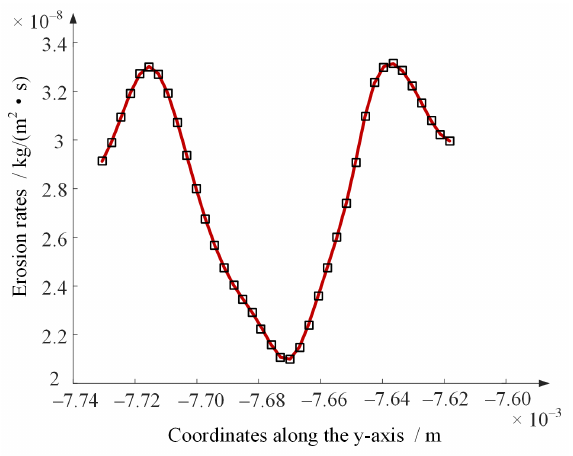
Figure 17. Erosion rates along the